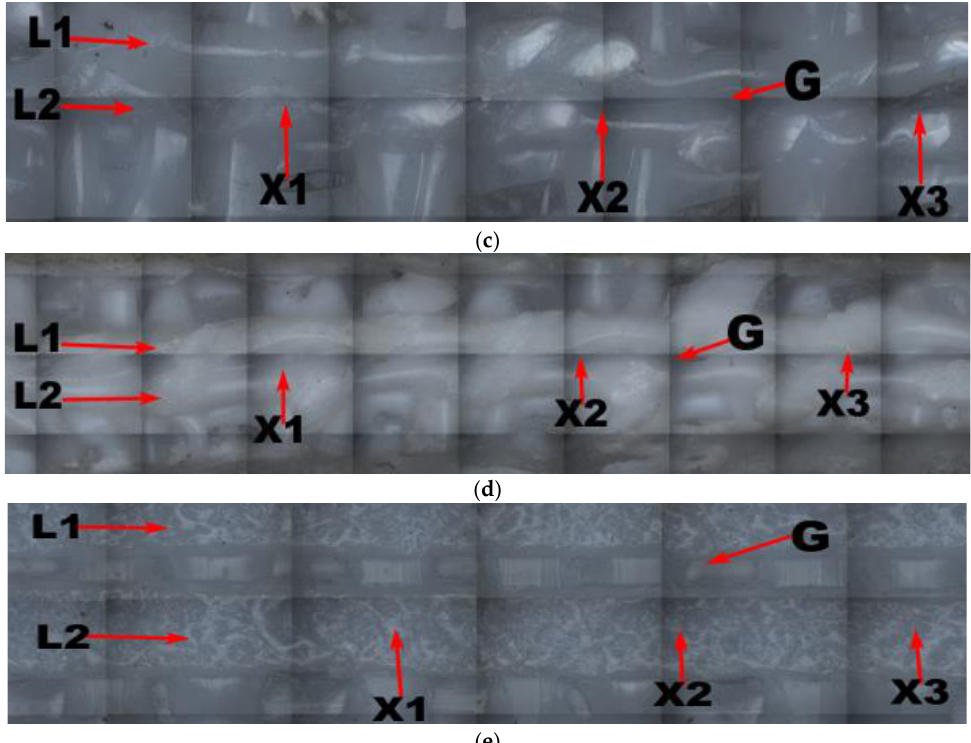
Figure 10. Two adjacent raster images of printed components under different conditions: ( a ) 70% linear support density and grating of z = 0.08; ( b ) 90% linear support density and grating of z = 0.08; ( c ) 70% linear support density and grating of z = 0.14; ( d ) 90% linear support density and grating of z = 0.14; ( e ) lower surface of unsupported printing member.